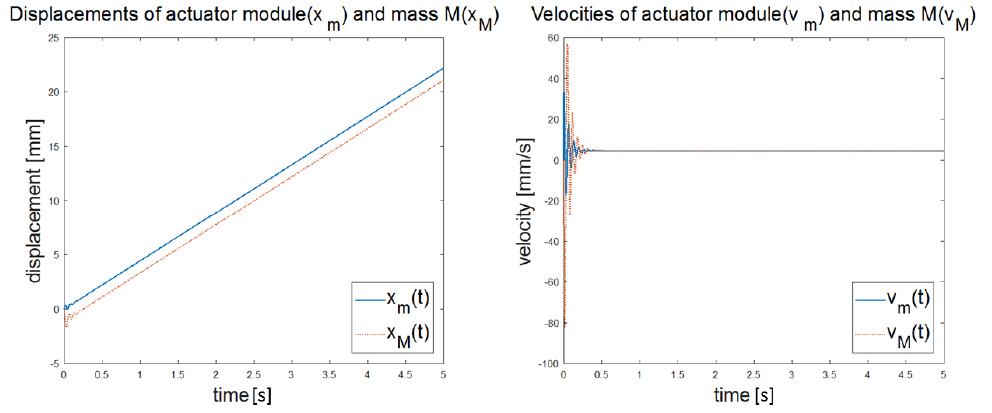
Figure 9. Displacement ( x m , x M ) and velocity ( v m , v M ) plots of the HSAM and the wire-attached mass M under Ω = 160 rev/s and M = 90